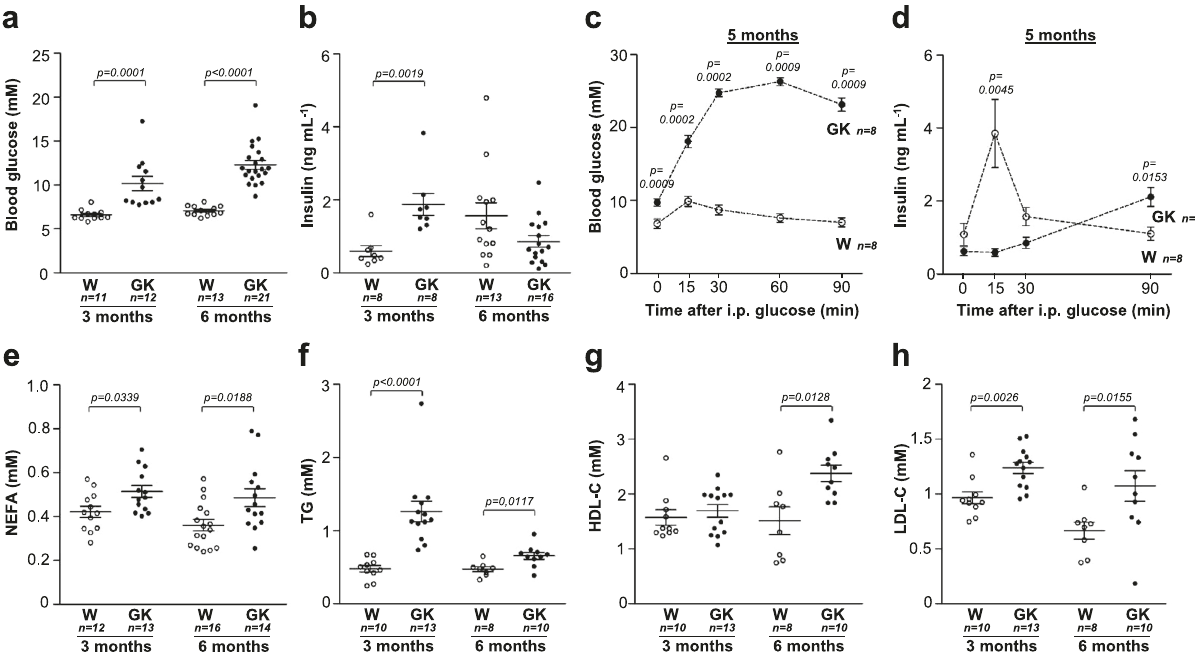
Fig. 1 Glucido-lipidic phenotype of Wistar and GK rats. a , b Assessment of blood glucose ( a ) and plasma insulin levels ( b ) in 3-month-old and 6-month- old Wistar (W, open symbols) and GK (closed symbols) rats. c , d Measurements of blood glucose ( c ) and plasma insulin levels ( d ) during an intraperitoneal glucose (i.p.) tolerance test performed on 5-month-old Wistar and GK rats. The data are represented as mean ± SEM. e – h Serum levels of non-esteri fi ed fatty acids (NEFA) ( e ), and plasma concentrations of triacylgycerols (TG) ( f ), HDL-cholesterol(-C) ( g ) and LDL-cholesterol (-C) ( h ) at 3 and 6 months. p -values are from two-sided Mann – Whitney U test for unpaired comparisons (GK vs. Wistar rats). Unless indicated data are represented as scatter blot with mean ± SEM. n represents the number of biologically independent animals in each group. Source data are provided as a Source Data fi